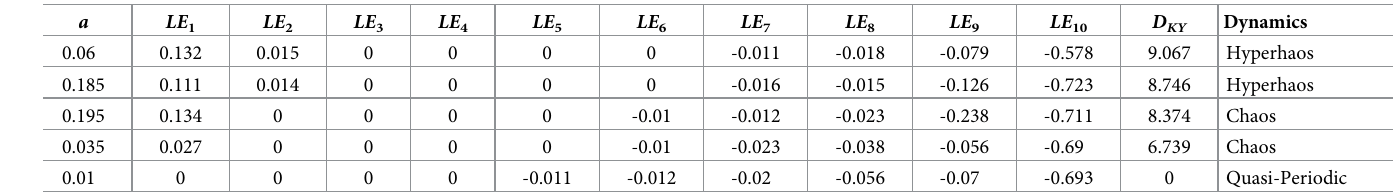
system (1) when and for initial conditions (3). From close observation of the figure, there is a good compatibility between Lyapunov exponents spectrum and the corresponding bifurcation diagram. When parameter c varies, we can see from Fig 7 that the new 10-D system (1) can exhibits periodic behavior with no complexity, chaotic behavior with one positive LE and a high fractional Kaplan-Yorke dimension, which illustrates complexity of the dynamics. In addition, higher complexity is observed when the proposed system generates a hyperchaotic behavior with more than one positive LE and higher values of fractional Kaplan-Yorke dimen- sion. When c ([0, 0.05], [0.13, 0.15], [0.24, 0.26], [0.45, 0.70], [2.36, 3]) the new system (1) gen- erates periodic behaviour where the corresponding Kaplan-Yorke fractal dimension equal to zero. When c ([0.06, 0.012], [0.17, 0.23], [0.27, 0.44], [0.71, 0.8], [1.92, 2.35], [2.65, 2.70], [2.85, 2.87]) the new 10-D system (1) involves into a chaotic attractor with different level of complex- ity. When c = 0.1, the value of Kaplan-Yorke fractal dimension is 6.676. This value may Table 2. Lyapunov exponents, Kaplan-Yorke dimensin and dynamics of the new 10D system (1) with parameter a